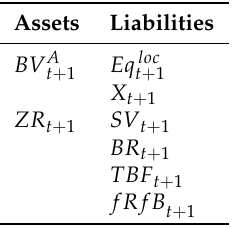
Table 1. Statutory balance sheet at time t +